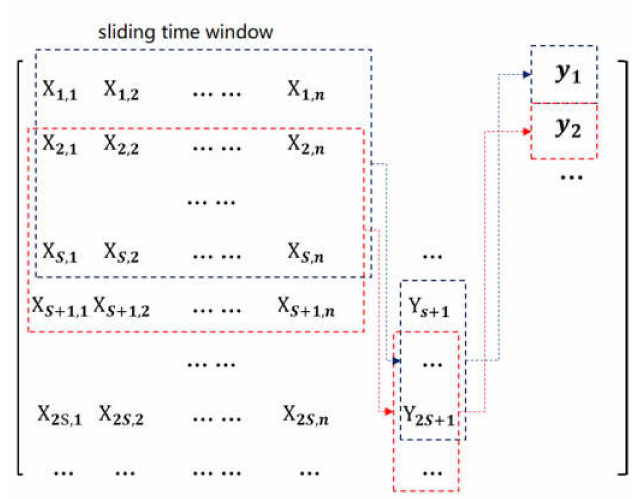
Figure 3. Sample label construction.